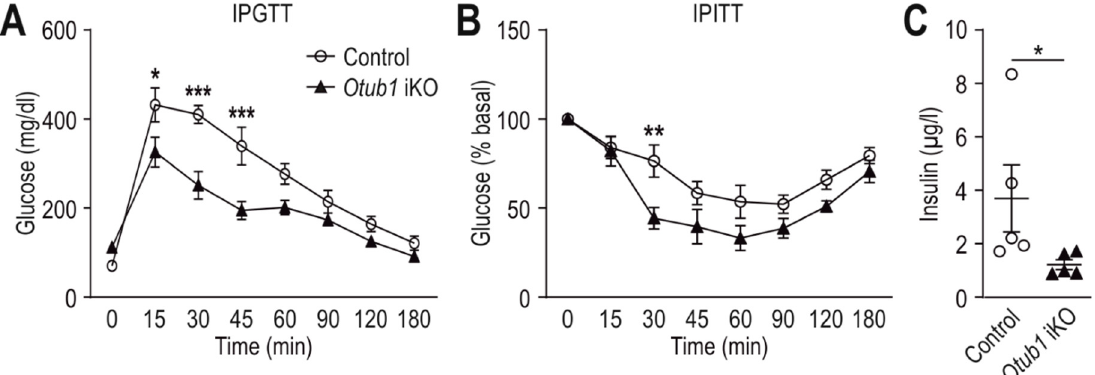
Figure 4. Insulin sensitivity of adult mice with induced Otub1 KO. ( A ) Intraperitoneal (IP) glucose tolerance test (IPGTT; 2 mg glucose/g; control, n = 4; Otub1 iKO, n = 5) and ( B ) IP insulin tolerance test (IPITT; 0.75 mU insulin/g; 4 months after Otub1 KO; 5.5-month-old mice; n = 5). ( C ) Plasma insulin levels in the mice shown in ( A ) and ( B ) (5 months after Otub1 KO; 6.5-month-old mice; n = 5) following 4 h of starvation during the light cycle. *, p < 0.05; **, p < 0.01; ***, p < 0.001 by two-way